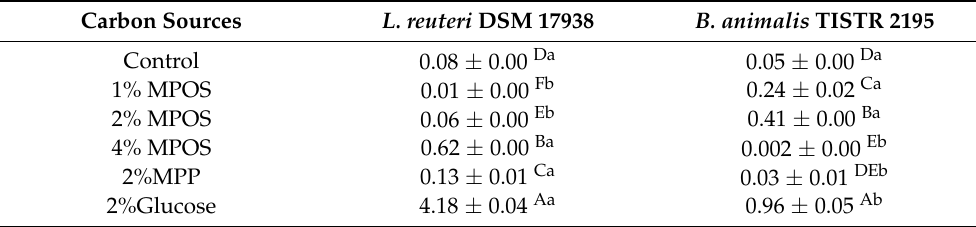
Table 2. ∆ LA/ ∆ SCFA of each probiotic bacterial strain in the media supplemented with different carbon sources cultivated for 72 h of fermentation